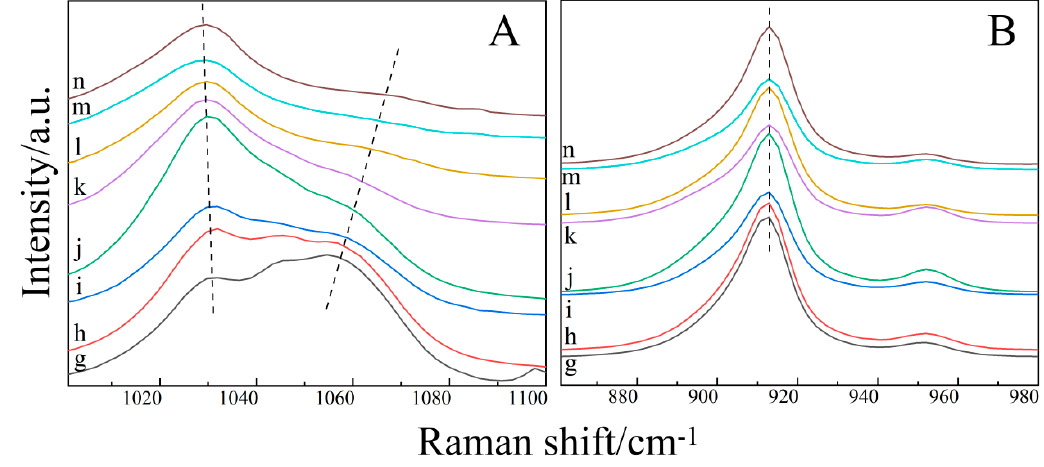
Figure 4. Raman shift of S = O ( A ) and C–O ( B ) vs. water content of the ternary solution.